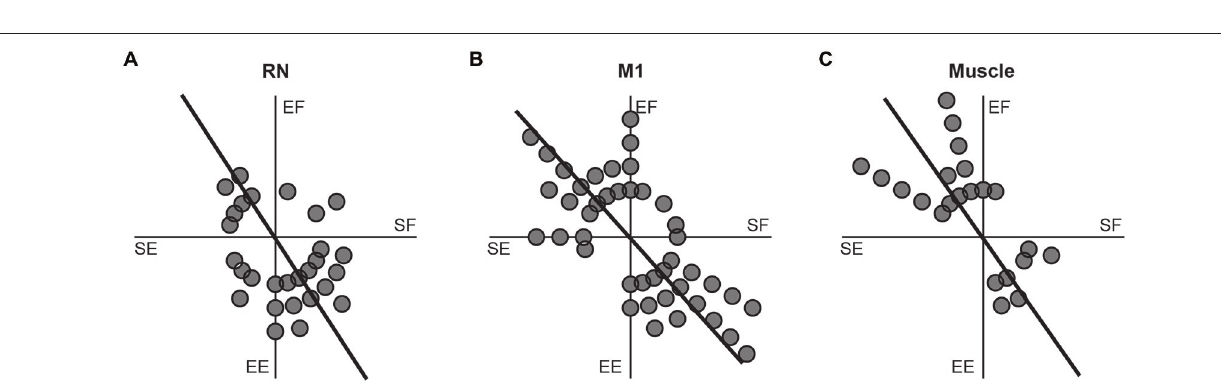
FIGURE 6 | Frequency histograms of preferred-torque directions . (A) RN neurons. (B) M1 neurons. (C) Upper-limb muscles. Each filled circle shows one neuron or muscle with a PTD within a 15 ◦ bin. Thick lines show the bimodal axes for each distribution of